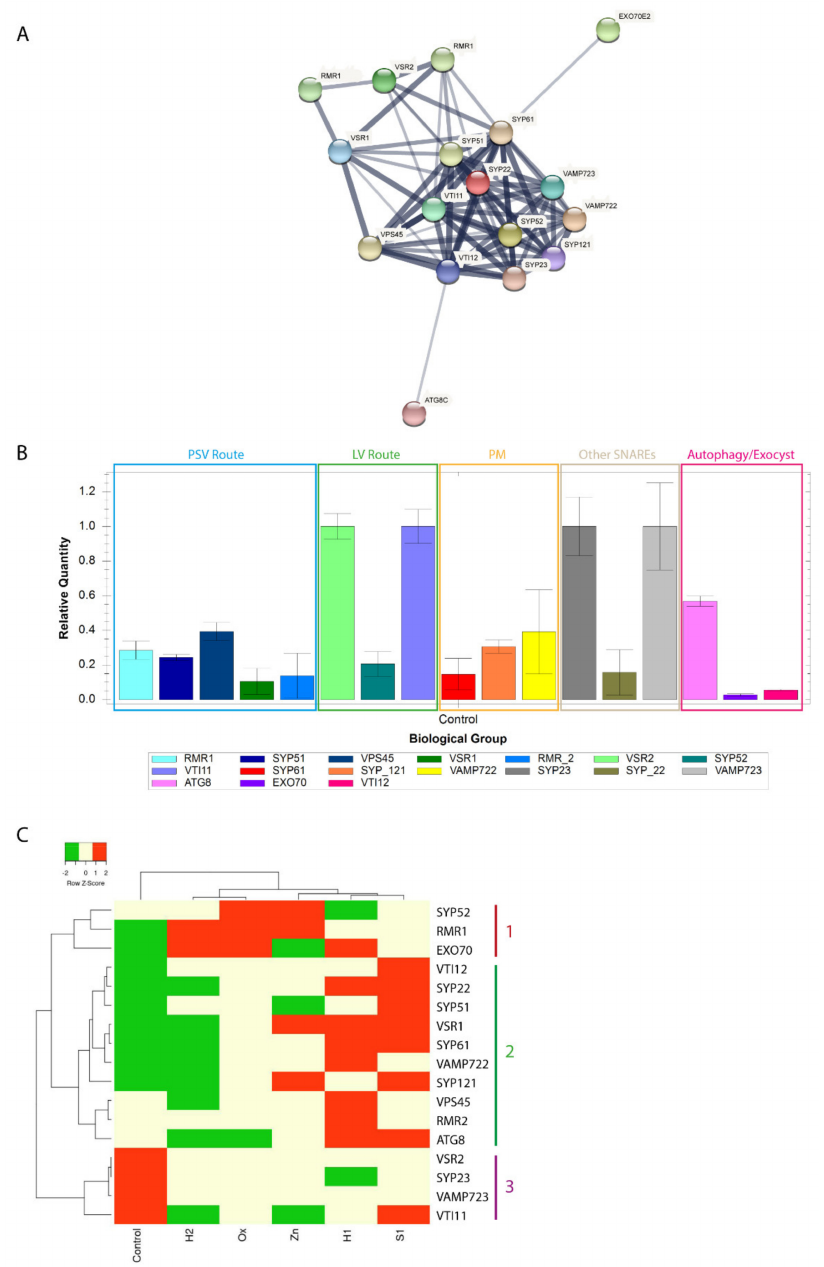
Figure 4. Differential analysis of the genes selected for the study. ( A ) Interaction network of the gene products selected in the study obtained using the String online software (https://version-11-0b.string- db.org/, accessed on 20 July 2021). Line thickness indicates the strength of data support; ( B ) heatmap of the Pearson correlation of the normalized gene expression data clustered by gene (rows) and stress (columns), obtained using the online software Heatmapper (http://www.heatmapper.ca/, accessed on 3 August 2021); ( C ) bar chart representing the relative quantity of all the genes under study in control condition. Coloured boxes represent the different groups organized for qRT-PCR